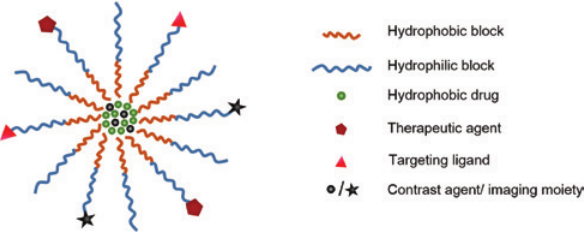
Figure 2: Schematic of optimized polymeric micelle for anticancer therapy, bearing targeting ligands, contrast agents or imaging moieties and therapeutic